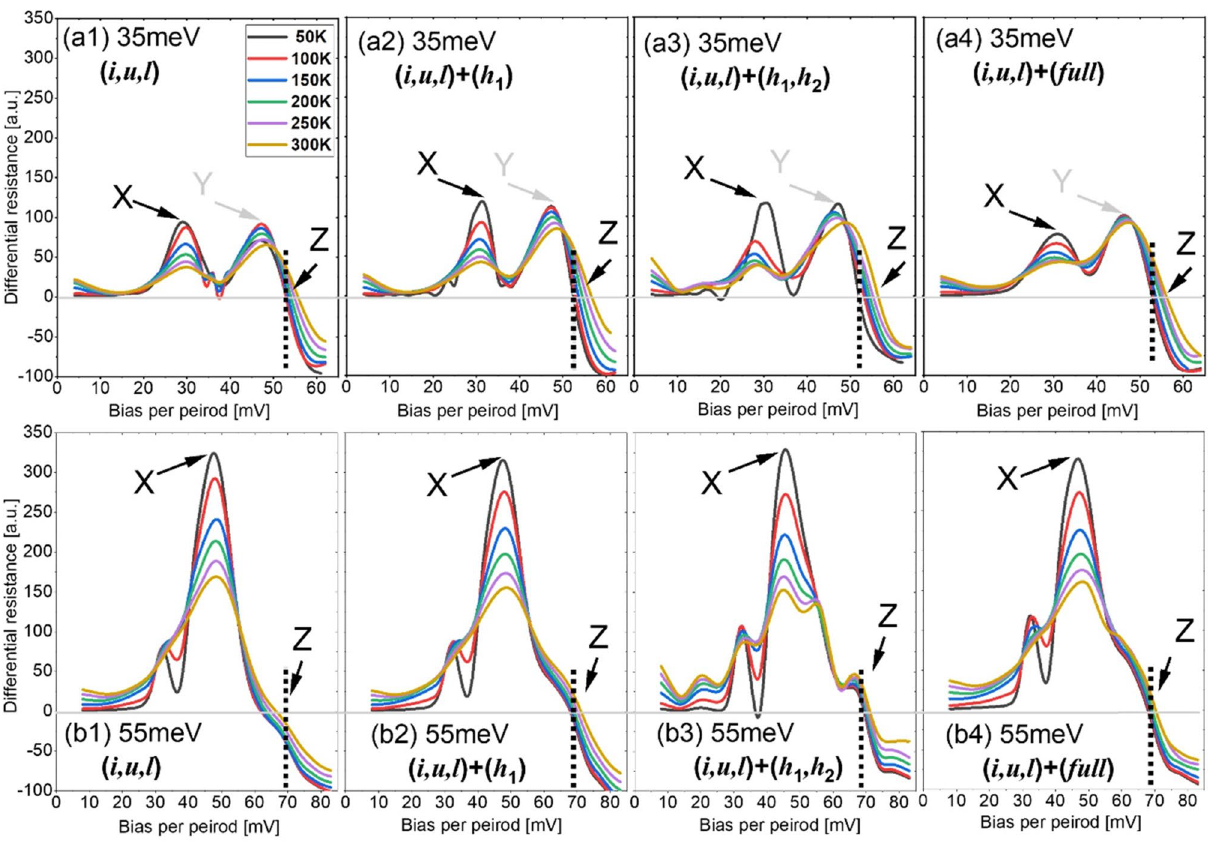
Figure 8. The differential resistances as functions of the bias at different temperatures, 35 meV design ( a1 – a4 ), 55 meV design ( b1 – b4 ). The X-peak indicates the pre-alignment condition, the Y-peak in figs ( a1 – a4 ) is the peak in the bias regime between the pre-alignment and operation, Z indicates the operating bias